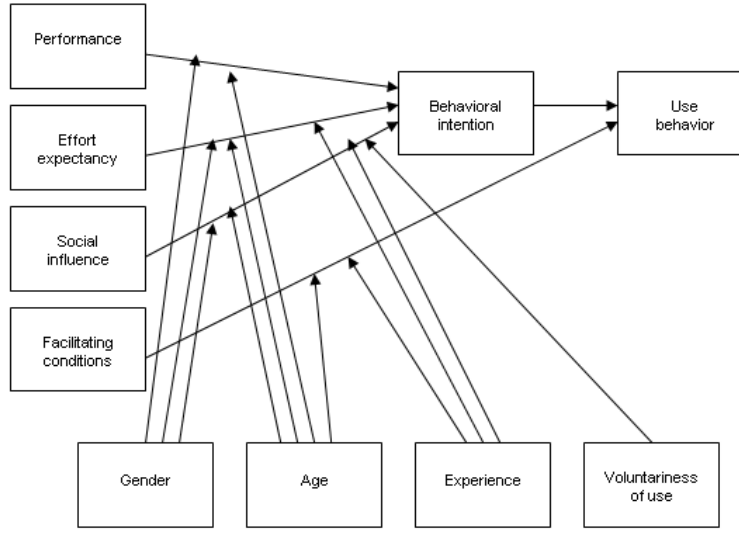
Figure 1. The Unified Theory of Acceptance and Use of